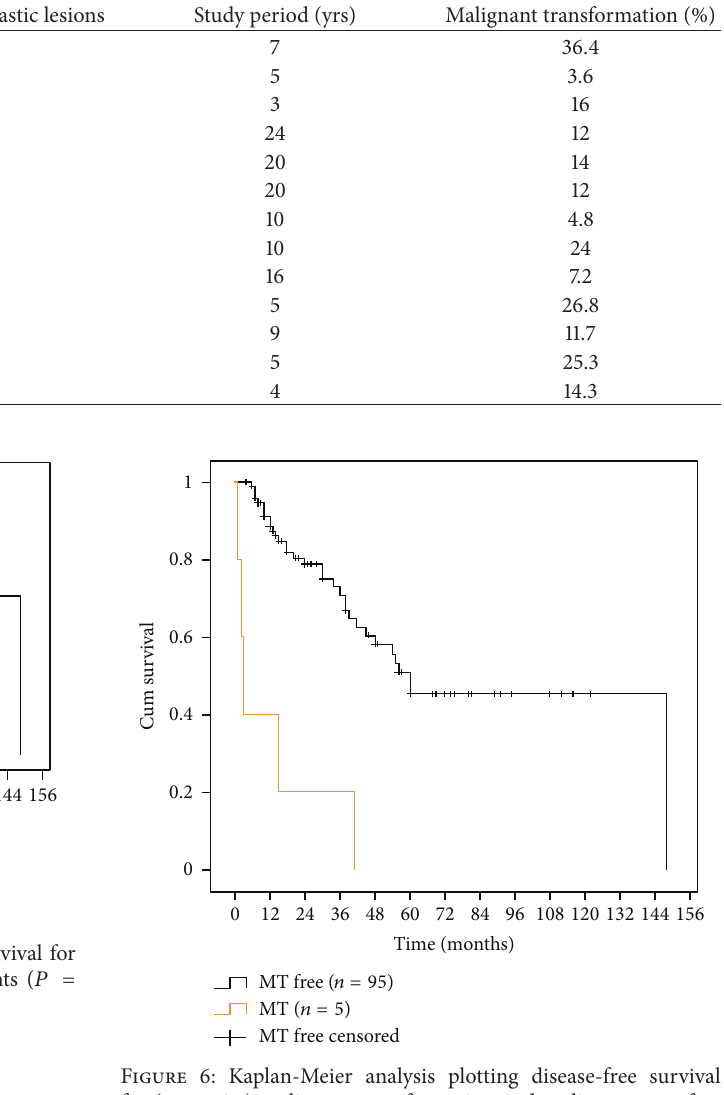
Table 4: Malignant transformation of dysplastic precursor lesions.